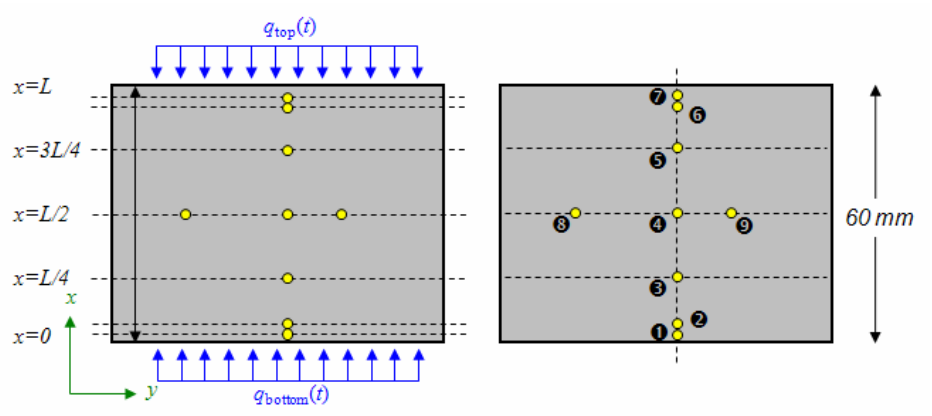
Fig. 3 Location of installed thermocouples in test